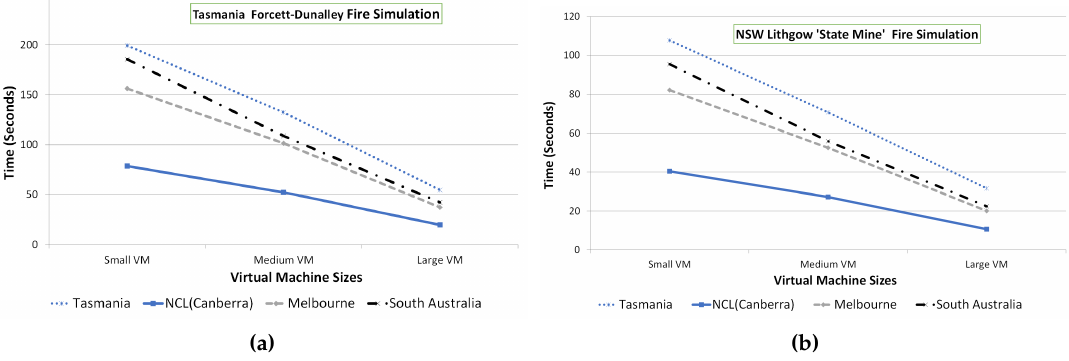
Figure 7. Spark benchmarking using real bushfire case studies. ( a ) Forcett-Dunalley, TAS; ( b ) Lithgow, state mine NSW